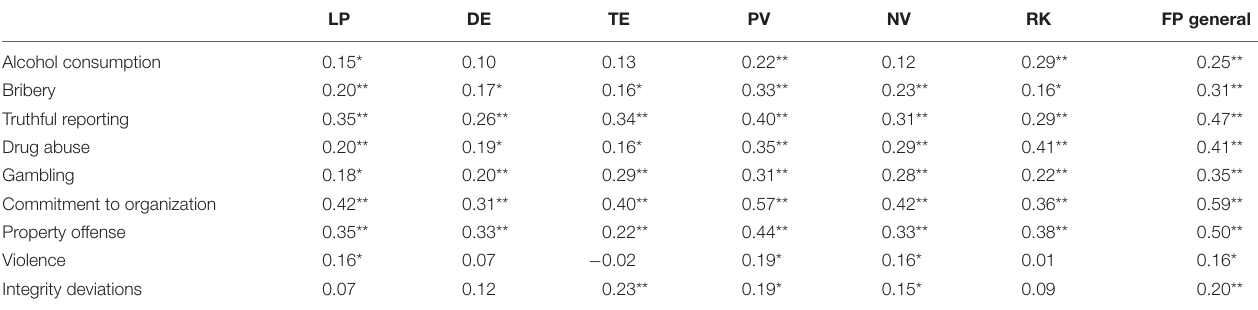
TABLE 8 | Correlations between integrity scales and FP